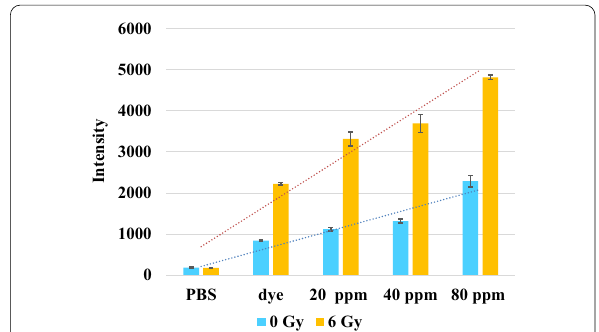
Fig. 2 Fluorescence expression of ROS kit in GNPs suspension versus various concentrations irradiated by 6 Gy Cs‑137. Kit for ROS: Carboxy‑H2DCFDA. Excitation wavelength: 495 nm, and emission wavelength: 529 nm for ELISA. Dash lines: linear regression